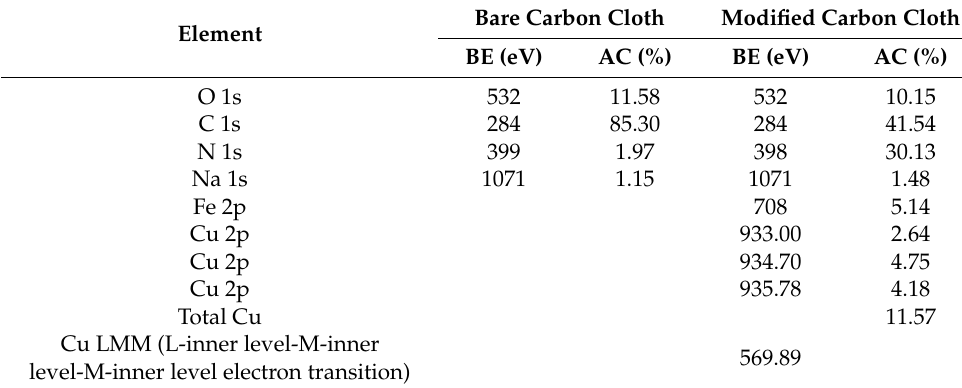
Table 1. Assignments of main spectral bands for carbon cloth and modified carbon cloth. The bands are based on their binding energies (BE) and atomic concentration